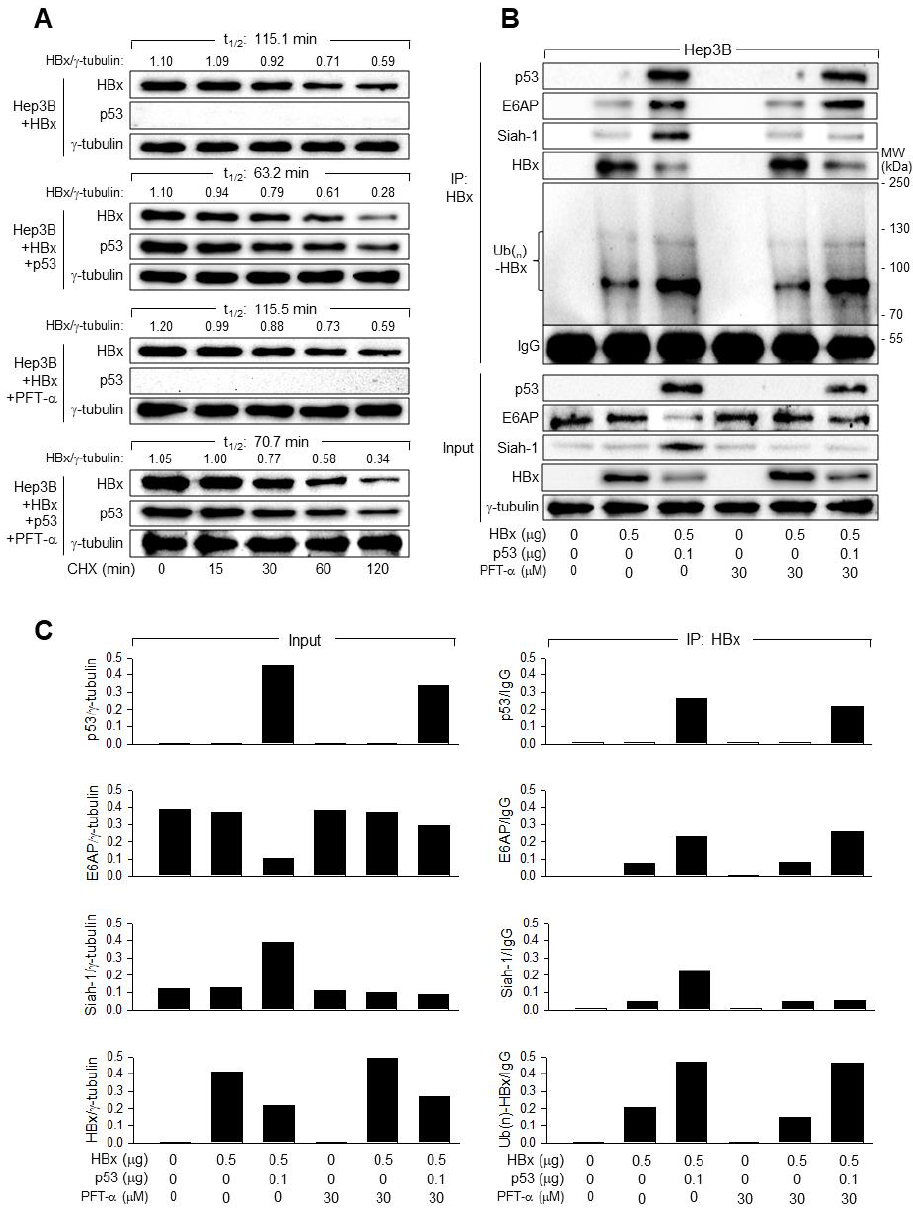
Figure 6. p53 induces ubiquitin-dependent proteasomal degradation of HBx. ( A ) Hep3B cells were transfected with HBx expression plasmid along with either an empty vector or p53 expression plasmids for 48 h in the presence or absence of 30 µ M PFT and treated with 50 µ M cycloheximide (CHX) for the indicated time before harvesting and Western blotting. The levels of HBx and γ -tubulin were quantified, as described in Figure 5A, to determine the half-life (t 1/2 ) of HBx. ( B ) Hep3B cells were transfected with HBx and HA-Ub expression plasmids along with either an empty vector or p53 expression plasmids for 48 h in the presence or absence of 30 µ M PFT- α . Total HBx protein in cell lysates was immunoprecipitated with an anti-HBx antibody and subjected to Western blotting using anti-p53, anti-E6AP, anti-Siah-1, anti-HBx, and anti-HA antibodies to detect p53, E6AP, Siah-1, HBx, and HA-Ub-complexed HBx, respectively. The input shows the levels of the indicated proteins in the cell lysates. ( C ) Each band in ( B ) was quantified as described in Figure 5A, and the values show the levels of each protein relative to γ -tubulin in the cell lysates (left) and the levels of each protein relative to IgG in the immunoprecipitates